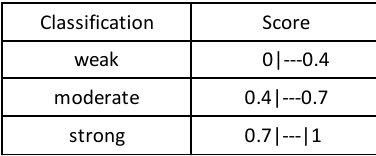
Table 3 . Classification of studies based on their